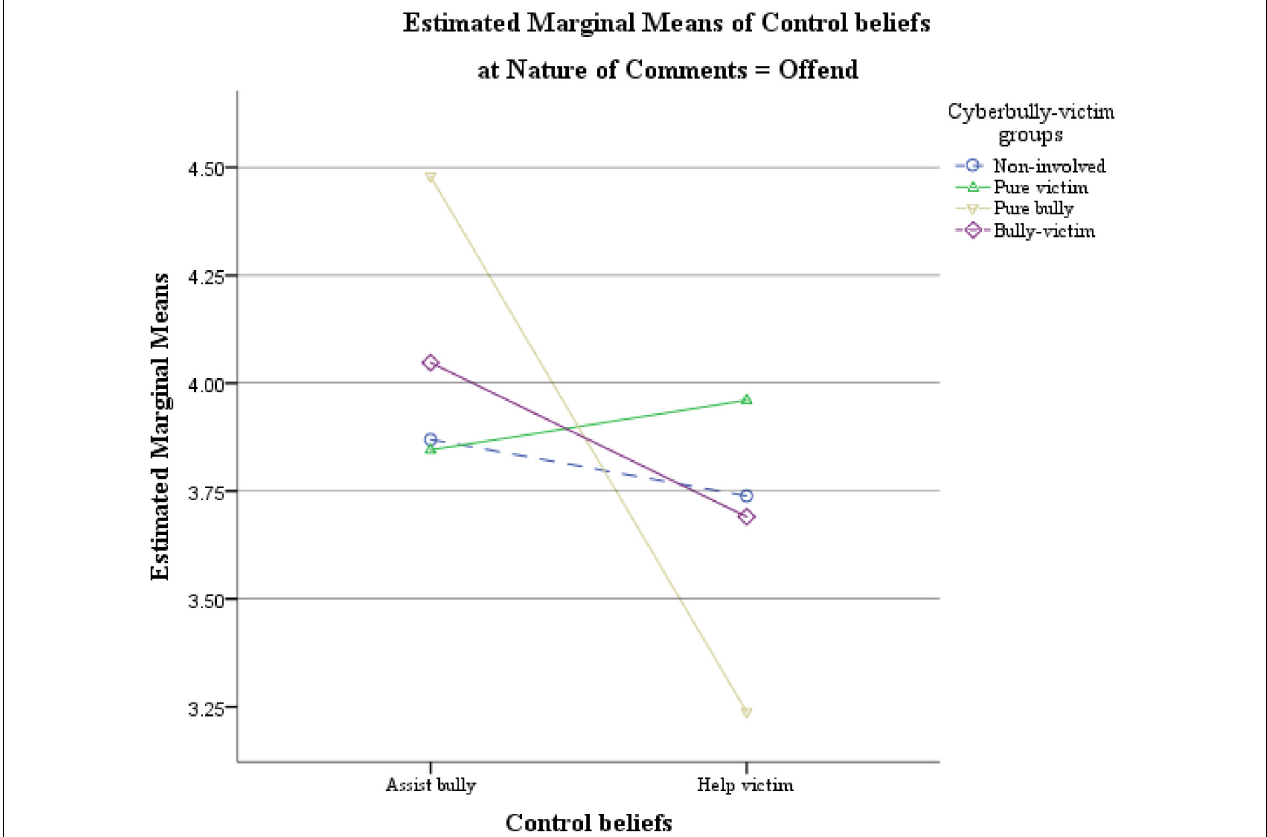
FIGURE 3 | Estimated marginal means of the 2-way interaction between cyberbully-victim group and type of control beliefs about bystander behaviors in the offend